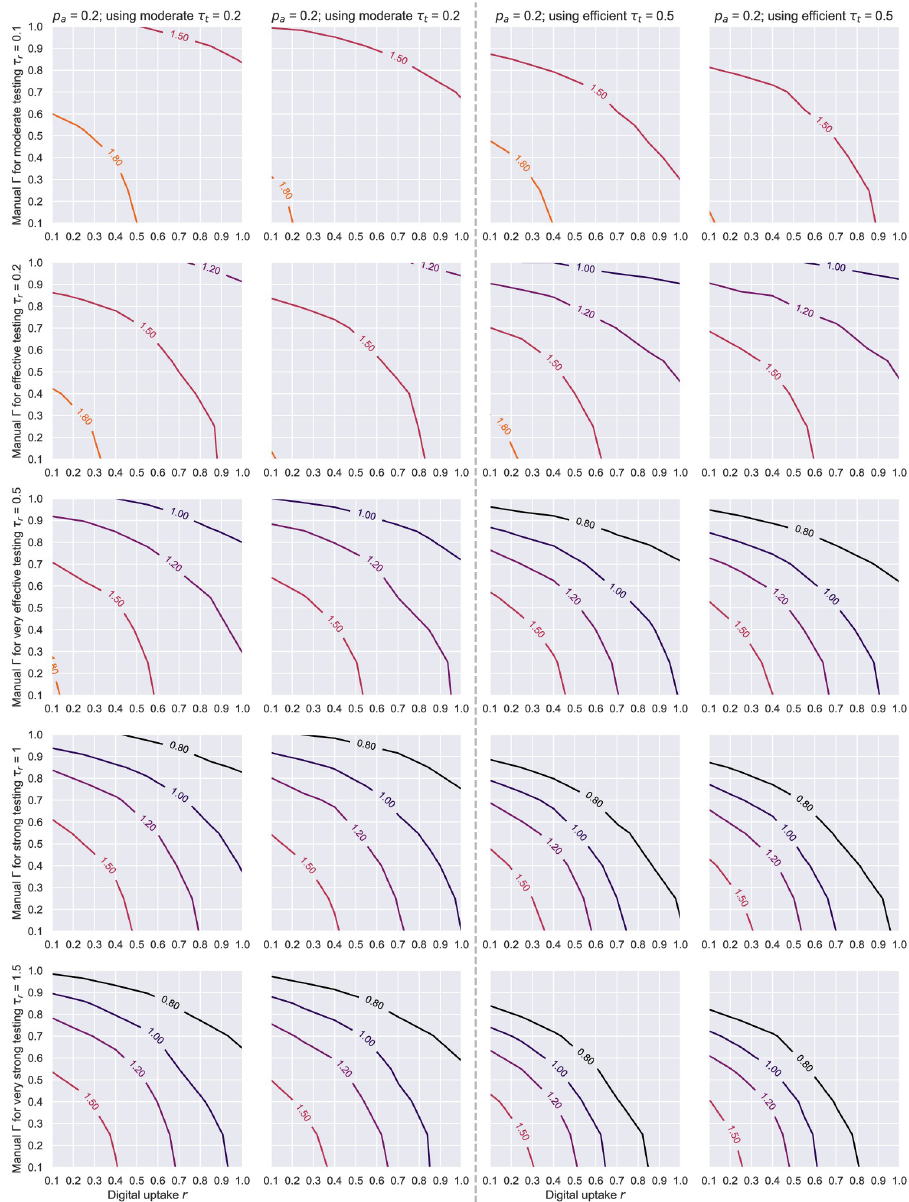
Fig 19. Social evolution—Contour plots of R based on the level of manual tracing overlap Γ and digital tracing uptake r , for different p a values. The results here correspond to the data-driven Social Evolution network when η = .001, with each pair of charts describing p = 0.2 on the left and p = 0.5 on the right. Each line represents a different a a testing level τ r , while the columns showcase combinations of one p a value together with a level of tracing effort given by τ t